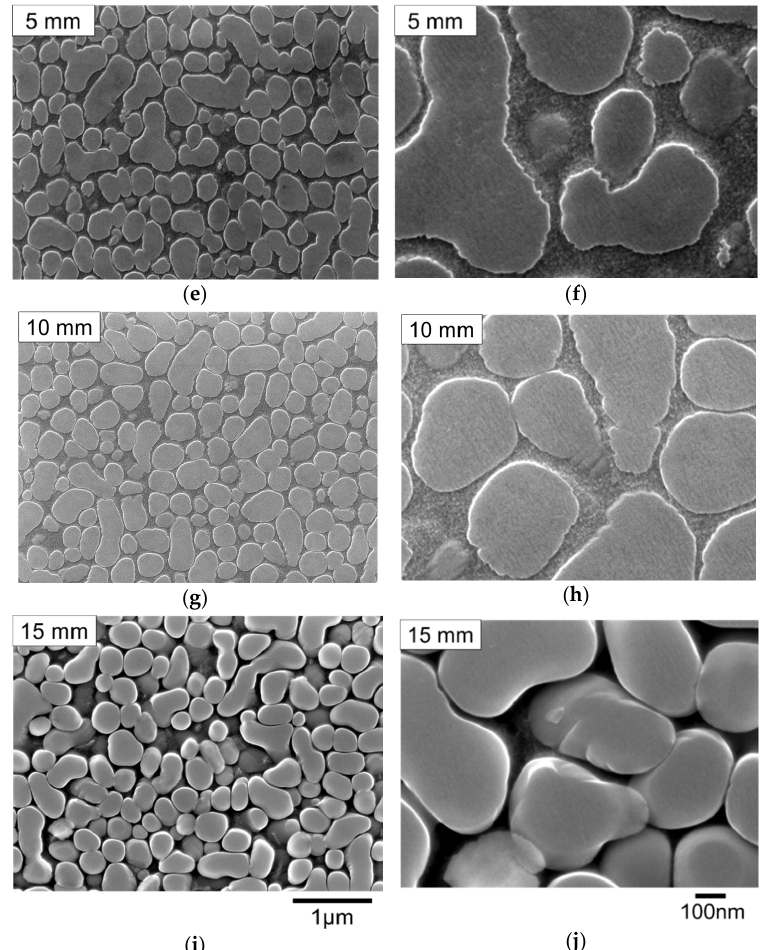
Figure 7. Microstructure parallel to the applied stress axis in a creep-ruptured specimen at a condition of 760 °C and 520 MPa. ( a , b ) Near the ruptured surface, ( c , d ) 2, ( e , f ) 5, ( g , h ) 10, ( i , j ) 15 mm away from the ruptured surface. Except for the region 15 mm from the ruptured surface, observed regions were within gauge of the specimen.